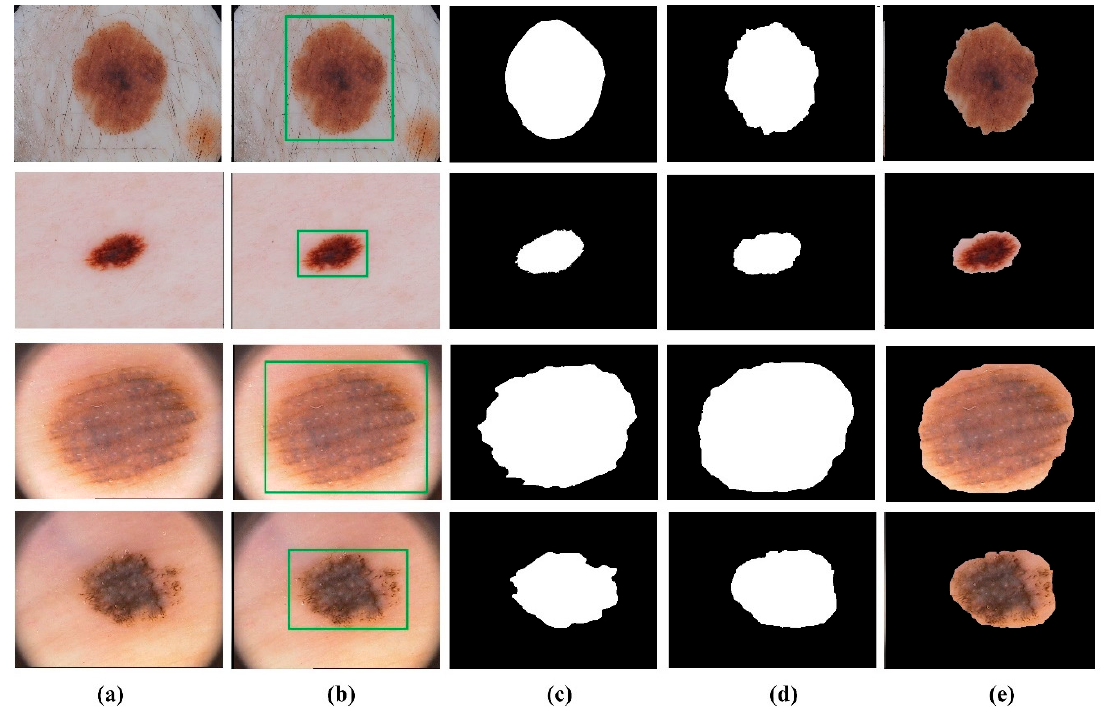
Figure 13. Skin lesion segmentation results of the proposed method. ( a ) Original image, ( b ) lesion location detection by Yolov3, ( c ) ground truth, ( d ) segmented lesion area by GrabCut and, ( e ) the final result.